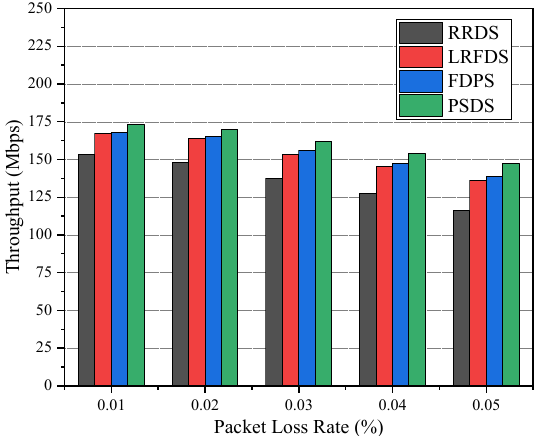
Figure 7. Average throughput under di ff erent packet loss rates.